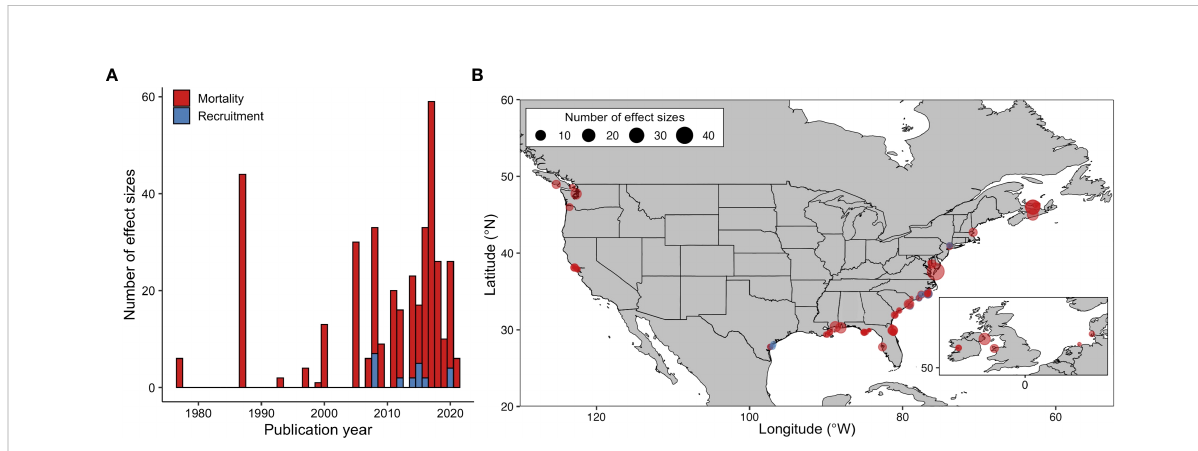
Supplementary Material: Figure S12A, Table S3) and latitude